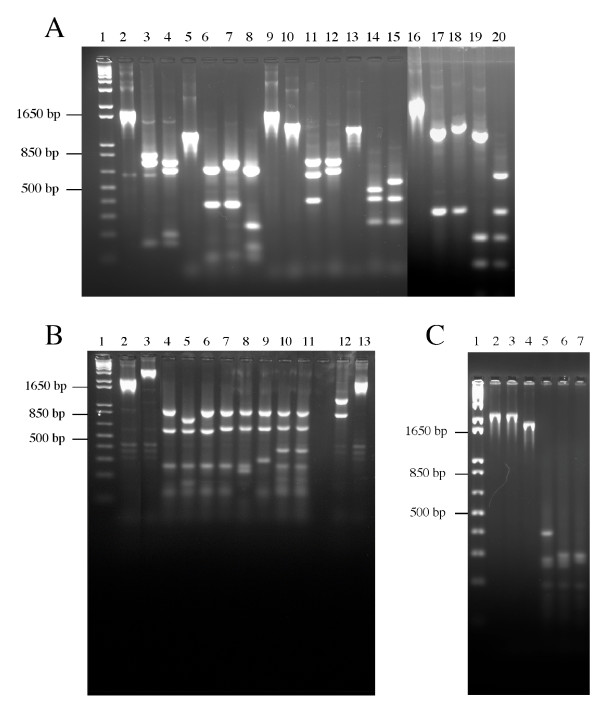
PCR-RFLP analysis of Brucella LPS genes manAO-Ag, manBO-Ag, wbkD, wbkF, wboA and wa**. Panel A. Lanes: 1, molecular size markers; 2, manAO-Ag from B. melitensis 16 M uncut; 3, manAO-Ag from B. melitensis 16 M cut by AvaII; 4, manAO-Ag from B. neotomae cut by AvaII; 5, wbkF from B. melitensis 16 M uncut; 6, wbkF from B. melitensis 16 M cut by AluI; 7, wbkF from B. melitensis bv2 cut by AluI; 8, wbkF from B. abortus bv2 cut by AluI; 9, wbkF2* from B. melitensis 16 M uncut; 10, wbkF2* from B. canis uncut; 11, wbkF2* from B. melitensis 16 M cut by EcoRV; 12, wbkF2* from B. canis cut by EcoRV; 13, wboA from B. melitensis 16 M uncut; 14, wboA from B. melitensis 16 M cut by AluI; 15, wboA from B. abortus cut by AluI; 16, wa** from B. melitensis 16 M uncut; 17, wa** from B. melitensis 16 M cut by AvaII; 18, wa** from B. suis bv2 cut by AvaII; 19, wa** from B. melitensis 16 M cut by HinfI; 20, wa** from B. ovis cut by HinfI. Panel B. Lanes: 1, molecular size markers; 2, manBO-Ag from B. melitensis 16 M uncut; 3, manBO-Ag from B. pinnipedialis uncut; 4, manBO-Ag from B. melitensis 16 M cut by Sau3A; 5, manBO-Ag from B. melitensis bv2 cut by Sau3A; 6, manBO-Ag from B. abortus cut by Sau3A; 7, manBO-Ag from B. suis cut by Sau3A; 8, manBO-Ag from B. suis bv2 cut by Sau3A; 9, manBO-Ag from B. ovis cut by Sau3A; 10, manBO-Ag from B. pinnipedialis cut by Sau3A; 11, manBO-Agfrom B. ceti cut by Sau3A; 12, manBO-Agfrom B. melitensis 16 M cut by EcoRV; 13, manBO-Ag from B. abortus cut by EcoRV. Panel C. Lanes: 1, molecular size markers; 2, wbkD from B. melitensis 16 M uncut; 3, wbkD from B. abortus uncut; 4, wbkD from B. canis uncut; 5, wbkD from B. melitensis 16 M cut by Sau3A; 6, wbkD from B. abortus cut by Sau3A; 7, wbkD from B. canis cut by Sau3A.